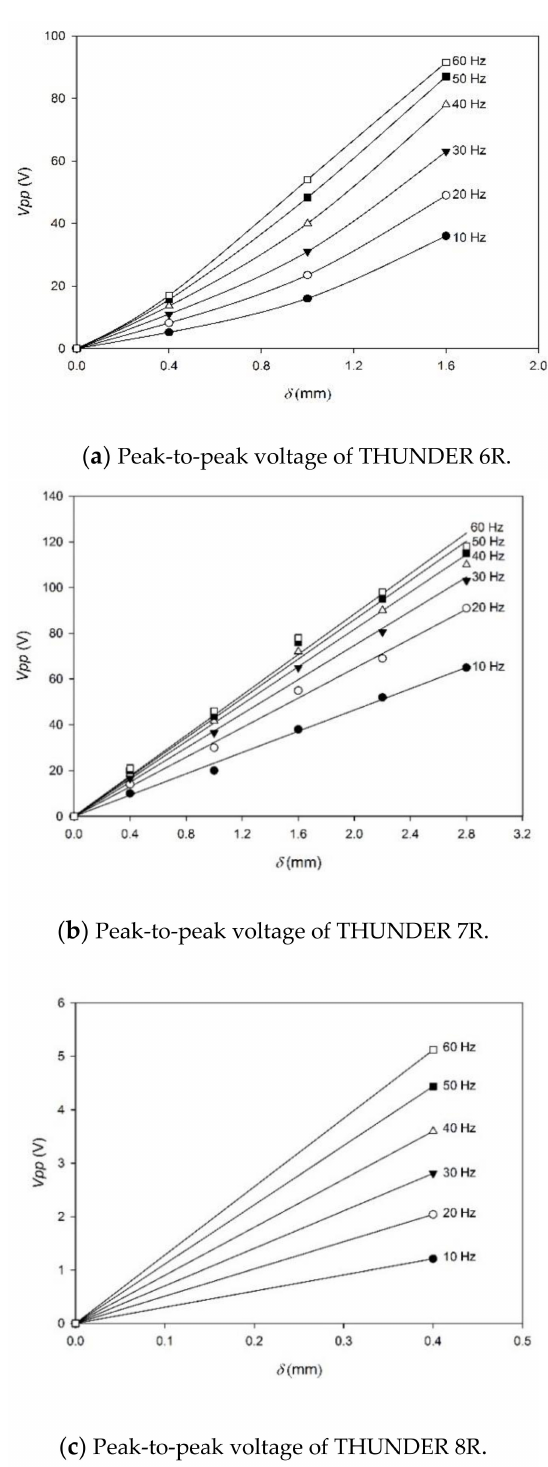
Figure 9. Variation of the peak-to-peak voltage with displacement for different frequencies at 30 ◦ C for the different THUNDER devices. ( a ) THUNDER 6R. ( b ) THUNDER 7R. ( c ) THUNDER